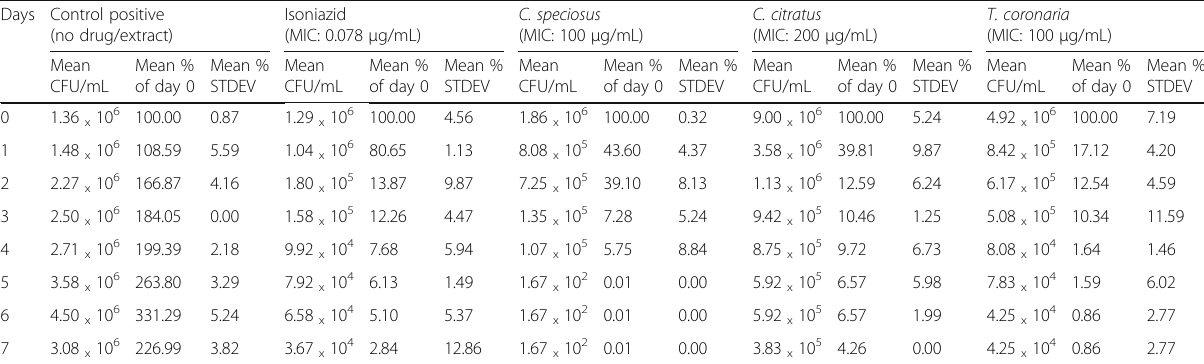
Table 3 Effects of n-hexane plant partitions on the colony counts of Mycobacterium tuberculosis H37Rv over 7-day treatment period Days Control positive (no drug/extract)